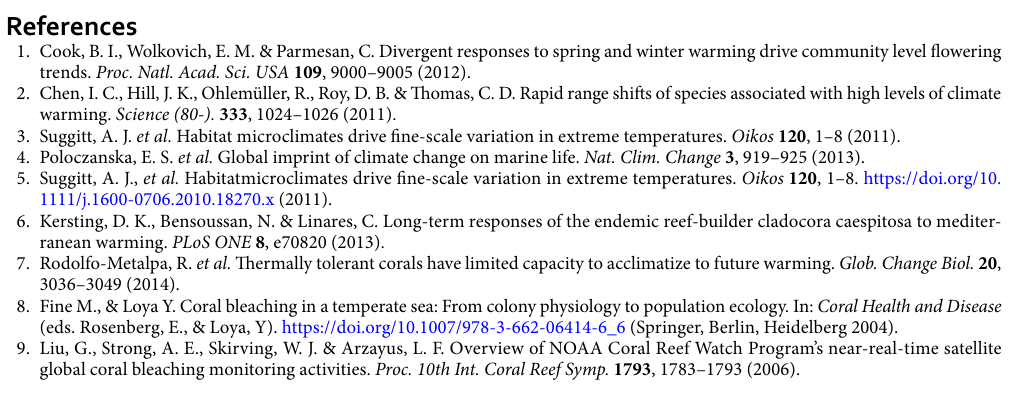
data (Table 1), a Kruskal Wallis test was implemented ( kruskal.test ::stats) 78 . Boxplot graphics were constructed ( ggplot ::ggplot2) and combined ( plot_grid ::cowplot) in R 80,81 . A principal component analysis (PCA) and analy- sis of similarities (ANOSIM) was conducted based on the Euclidean distance resemblance matrix as a response variable. Data cited in the text are mean ± standard